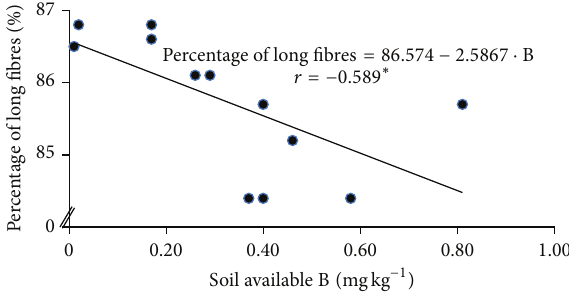
Figure 2: Effect of boron content of soil on percentage of long fibre in the 2006 experiment ( ∗ 𝑝 < 0.05 ).